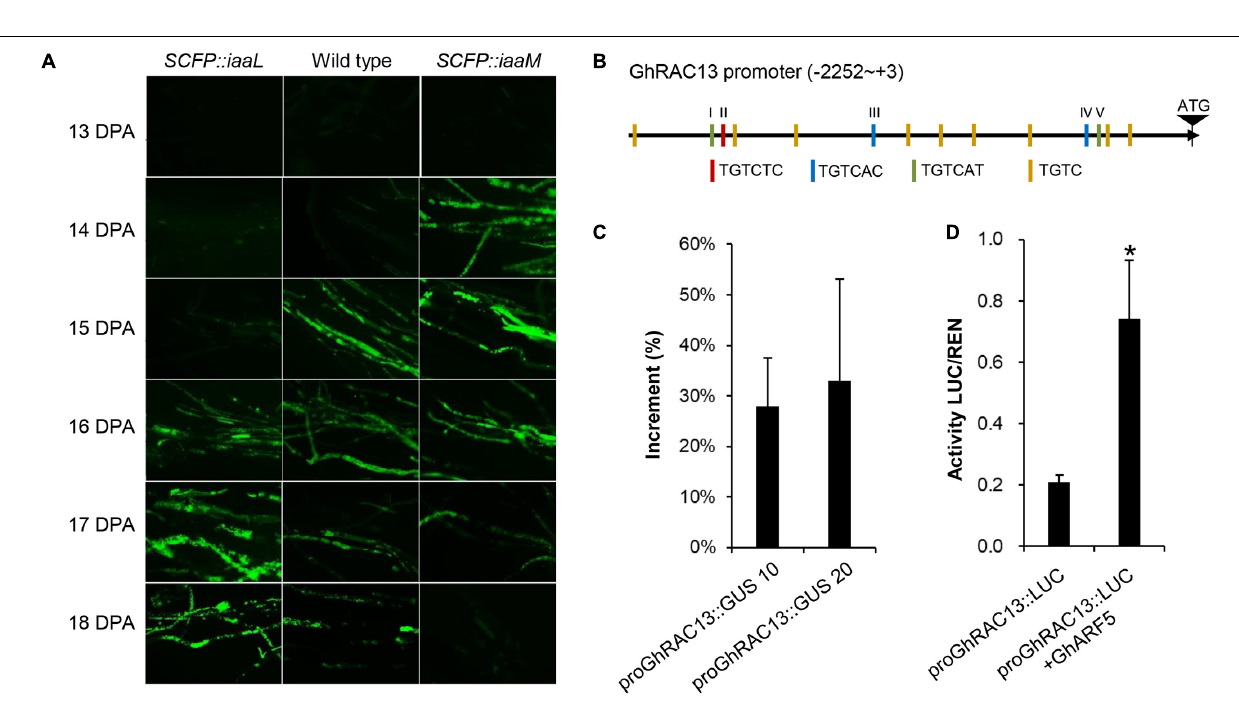
Frontiers in Plant Science |